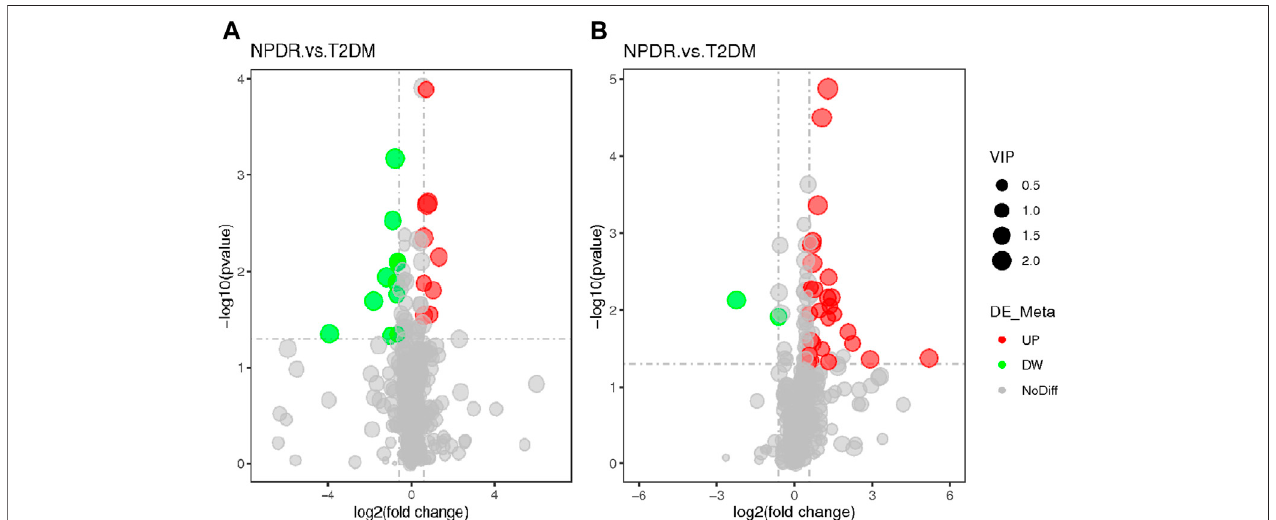
FIGURE 4 | (A) Positive mode. (B) Negative mode. The volcano map of the log2 (FC) and − log10 ( p -value) shows that 93 features were signi fi cantly different between NPDR patients ( n = 15) and T2DM patients ( n = 15). Signi fi cant metabolic features that increased (red dots) or decreased (green dots) in NPDR patients compared with T2DM patients are indicated, and the dot size represents the VIP value. In the positive mode, compared with T2DM patients, 12 metabolic features increased signi fi cantly and 14 metabolic features decreased signi fi cantly in NPDR patients. In the negative mode, compared with T2DM patients, 35 metabolic features increased signi fi cantly and 6 metabolic features decreased signi fi cantly in NPDR patients.